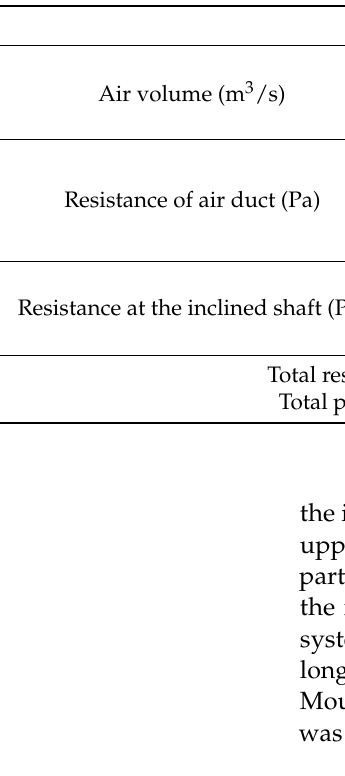
Table 4. Energy consumption of air cabin ventilation